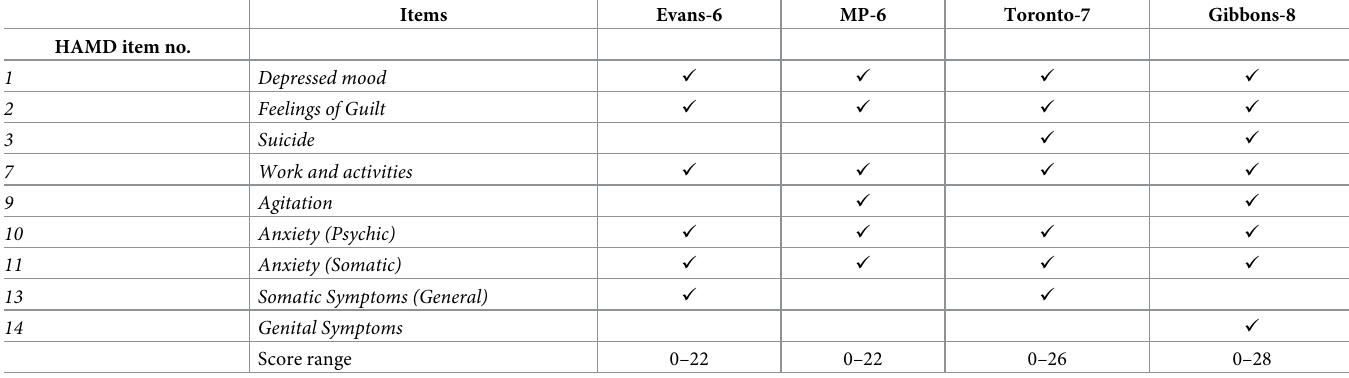
Table 1. Hamilton depression rating scale (HAMD) subscales and their items. Items Evans-6 MP-6 Toronto-7